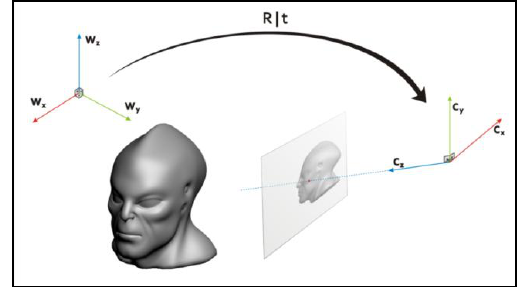
Figure 1. The 3D object, its projection onto the image plane and the relation between world and camera coordinate systems.